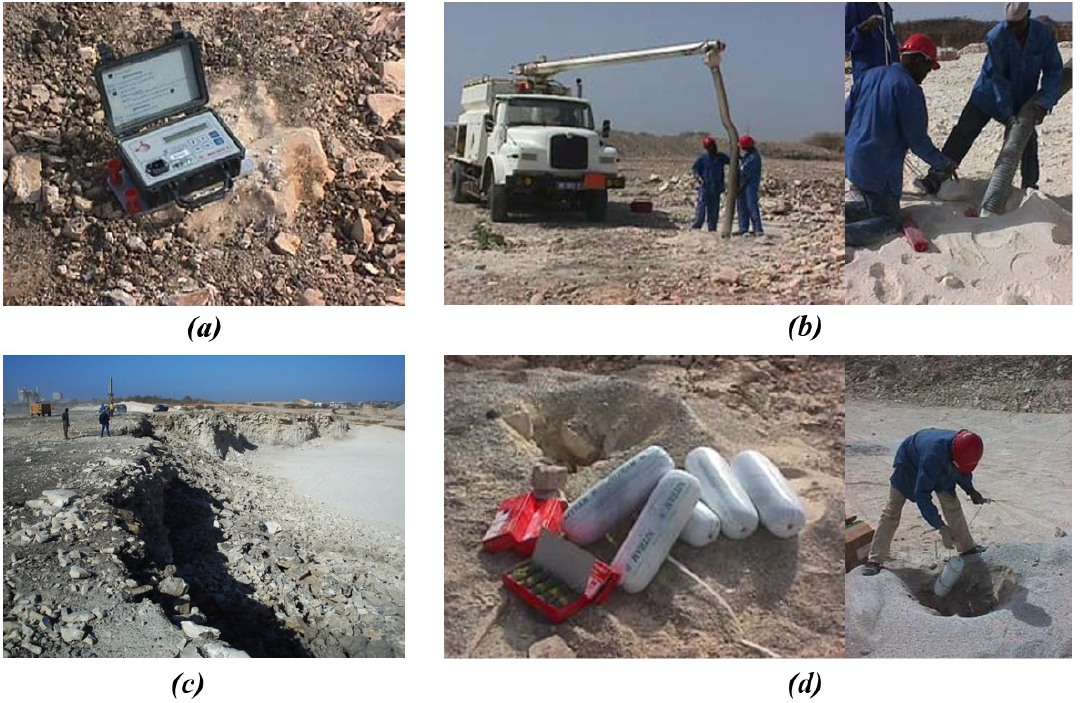
Figure 2: (a) Vibration monitoring sensor; (b) ANFO truck loader; (c) Blast area inspection; (d) Bottom charge with cartridges and electric detonators.